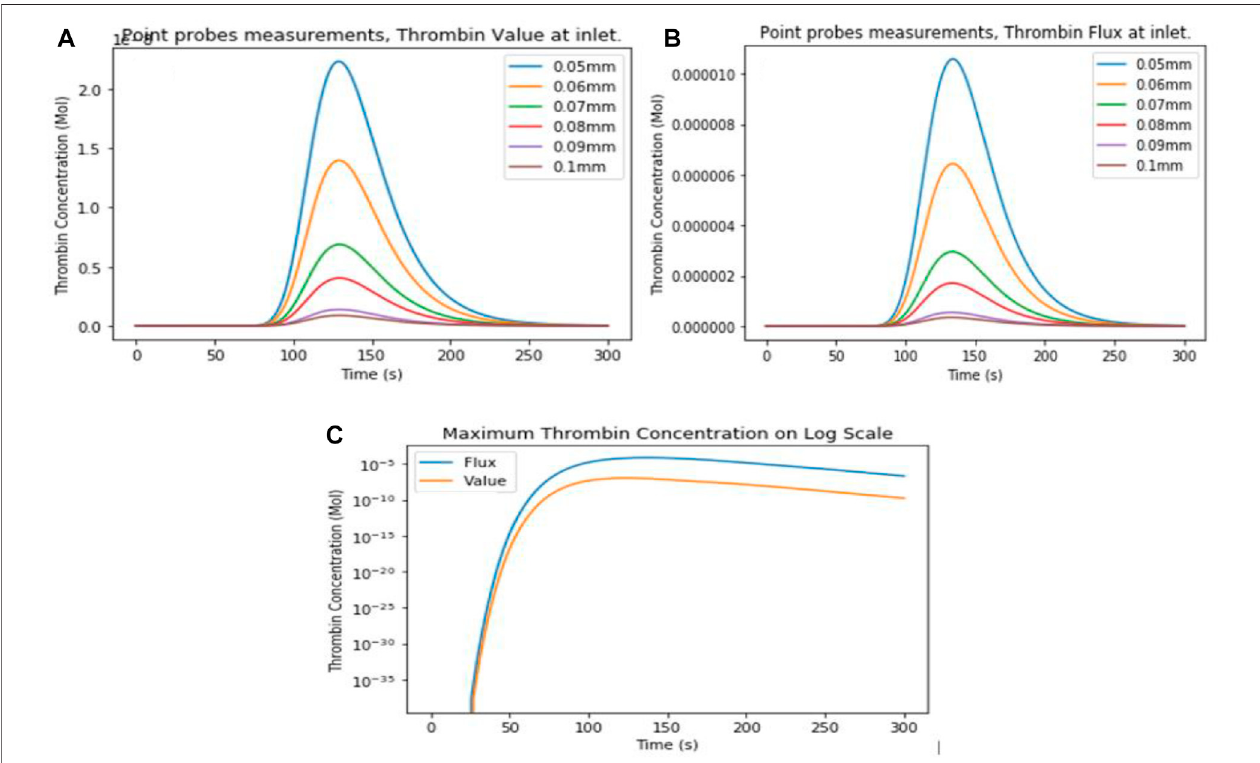
FIGURE 3 | Two-dimensional model point probes measuring thrombin concentration at different distances from the injury site for (A) value and (B) fl ux boundary conditions at the thrombin inlet. (C) Comparison of maximum thrombin concentration in the vein between both boundary conditions on a logarithmic scale.